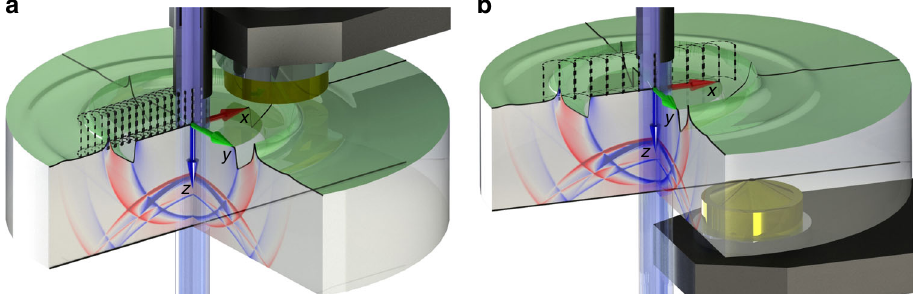
Fig. 1 Experimental setup and geometry. The perspective view on the central part of the experimental setup with the sensor deployed on the HR surface ( a ) and on the opposite (uncoated) facet ( b ) for a beam-center to sensor-center separation of x = 12 mm. The x , y , and z axes of the Cartesian coordinate system have the origin at the intersection of the HR surface and the symmetry axis of the beam. For visualization purposes, a part of the sample has been cutout. The laser beam pulse (indigo) impinges on the HR surface (green top layer) of the cylindrical sample (grey) through a tube (black), which prevents scattered light from reaching the sensor head (gold) fi xed in the holder arm (dark grey). A minute amount of light (pale blue) is transmitted through the HR layer. The radiation pressure launches elastic waves, which spread away from the source and carry the momentum and energy transferred from the laser pulse. The calculated out-of-plane displacement at time t = 1.96 μ s after initial pulse re fl ection is presented as ripples on the HR surface. The instantaneous z -velocity fi eld of the bulk waves is colour-coded on the cut-out sides of the sample, where the red colour represents positive and blue negative z -velocity. The other experimental positions of the incident beam are depicted with the